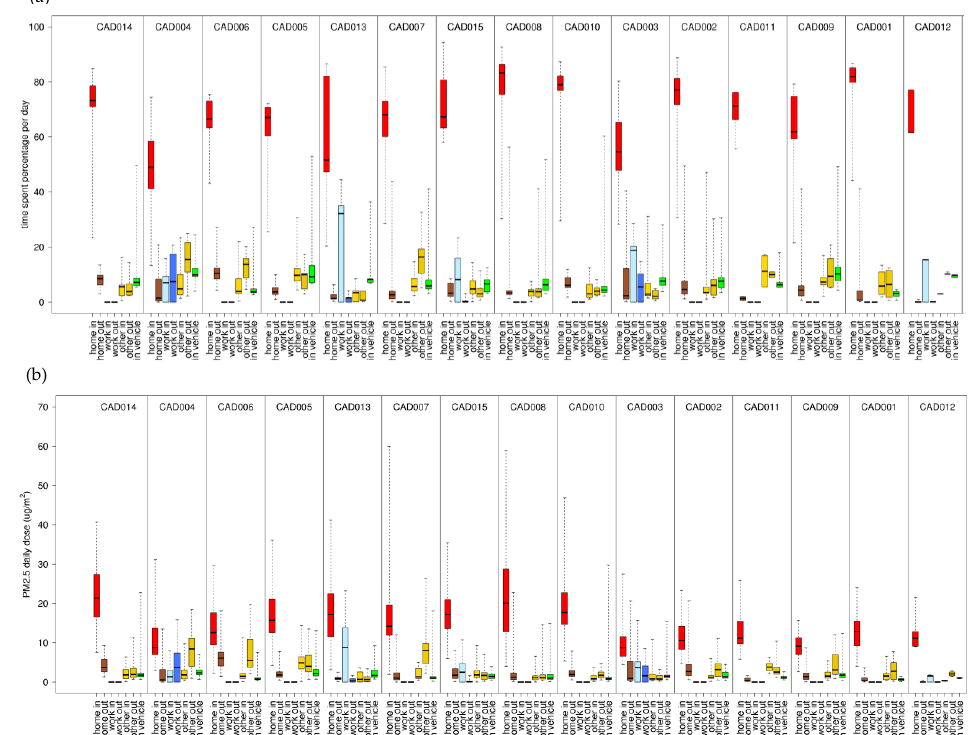
Figure 6. Percentage of daily time spent in ( a ) and inhaled dose for total PM 2.5 ( b ) for each microenvironment (indoors and outdoors at home, work, and other; inside vehicle) and each participant. Results (24 h average, 08:00–08:00) are sorted by median values of the total dose from highest to lowest. Shown are medians with 25th and 75th percentiles, and whiskers for minimum and maximum values.